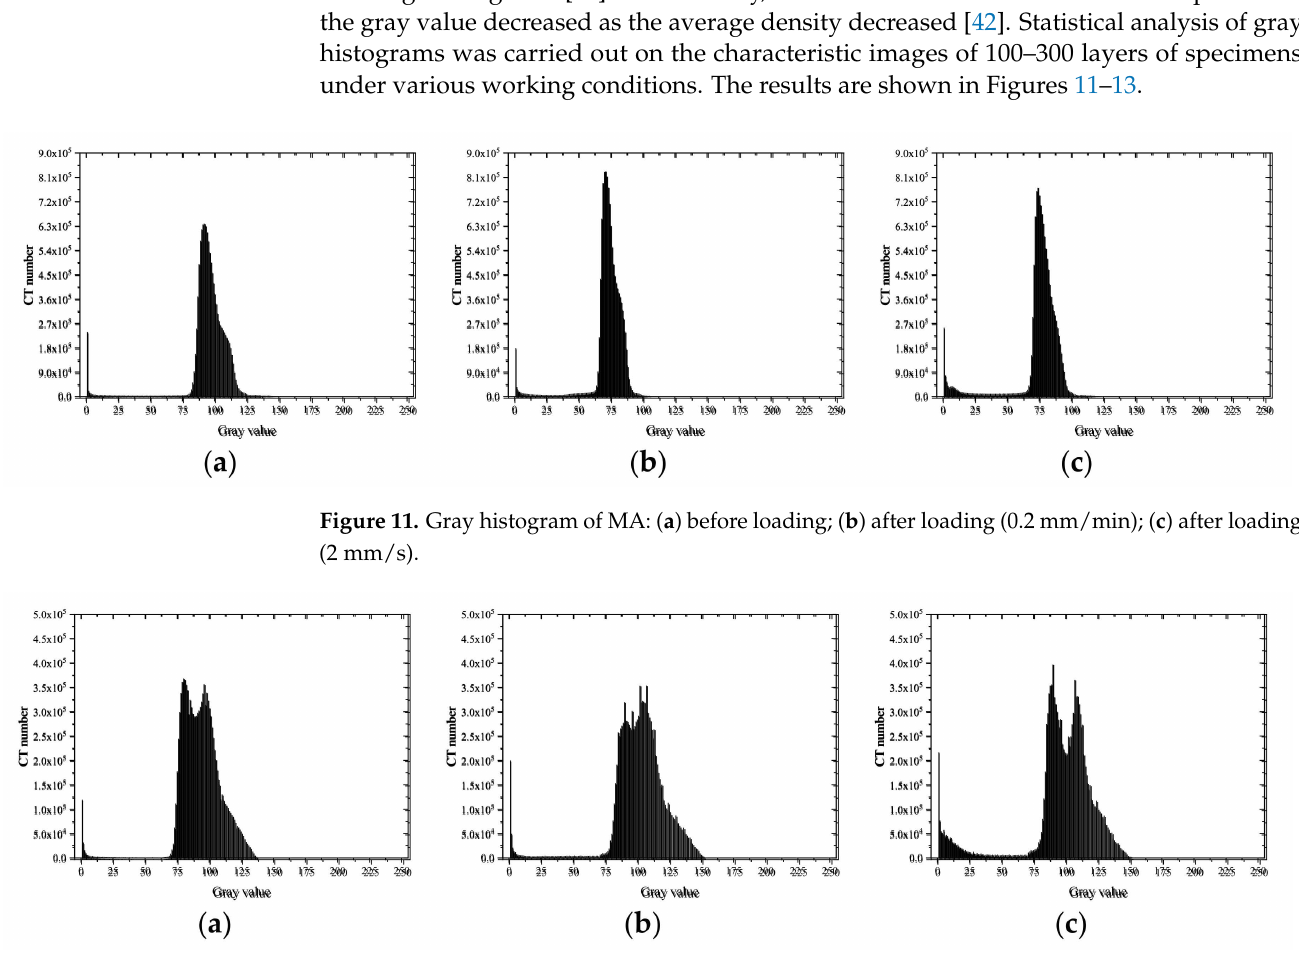
Figure 12. Gray histogram of CA: ( a ) before loading; ( b ) after loading (0.2 mm/min); ( c ) after loading (2